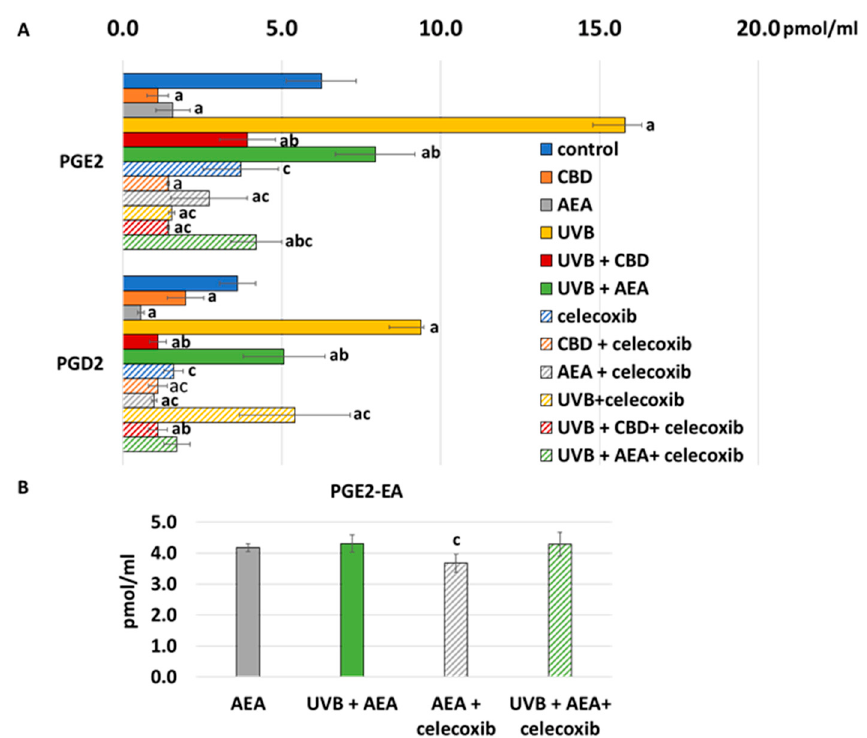
Figure 8. ( A ) Prostaglandins level in culture medium of control keratinocytes treated with CBD (4 μ M) or AEA (4 μ M) or irradiated with UVB (60 mJ/cm 2 ) as well as cells irradiated with UVB and treated with CBD or AEA (in the same concentrations) as well as their levels in keratinocytes after treatment with 20 μ M celecoxib alone and with CBD(4 μ M) or AEA(4 μ M) as well as cells irradiated with UVB and treated with CBD or AEA (in the same concentrations). (a)—statistically significant differences between keratinocytes treated with CBD, AEA, UVB, UVB + CBD, AEA + UVB and non-treated cells as well as keratinocytes treated with CBD + celecoxib, AEA + celecoxib, UVB + celecoxib, UVB + CBD + celecoxib and AEA + UVB+ celecoxib and cells treated only with celecoxib; p < 0.05; (b)—statistically significant differences between keratinocytes treated with UVB + CBD, UVB + AEA, UVB + CBD + celecoxib, AEA + UVB + celecoxib and irradiated with UVB p < 0.05; (c)—statistically significant differences between keratinocytes treated with celecoxib and corresponding keratinocytes not treated with celecoxib. ( B ) PGE2-EA levels in culture medium of control keratinocytes and treated with AEA (4 μ M) or irradiated with UVB (60 mJ/cm 2 ) and treated with AEA (4 μ M) or treated with 20 μ M celecoxib and AEA (4 μ M) or irradiated with UVB and treated with AEA and celecoxib in above abovementioned doses.